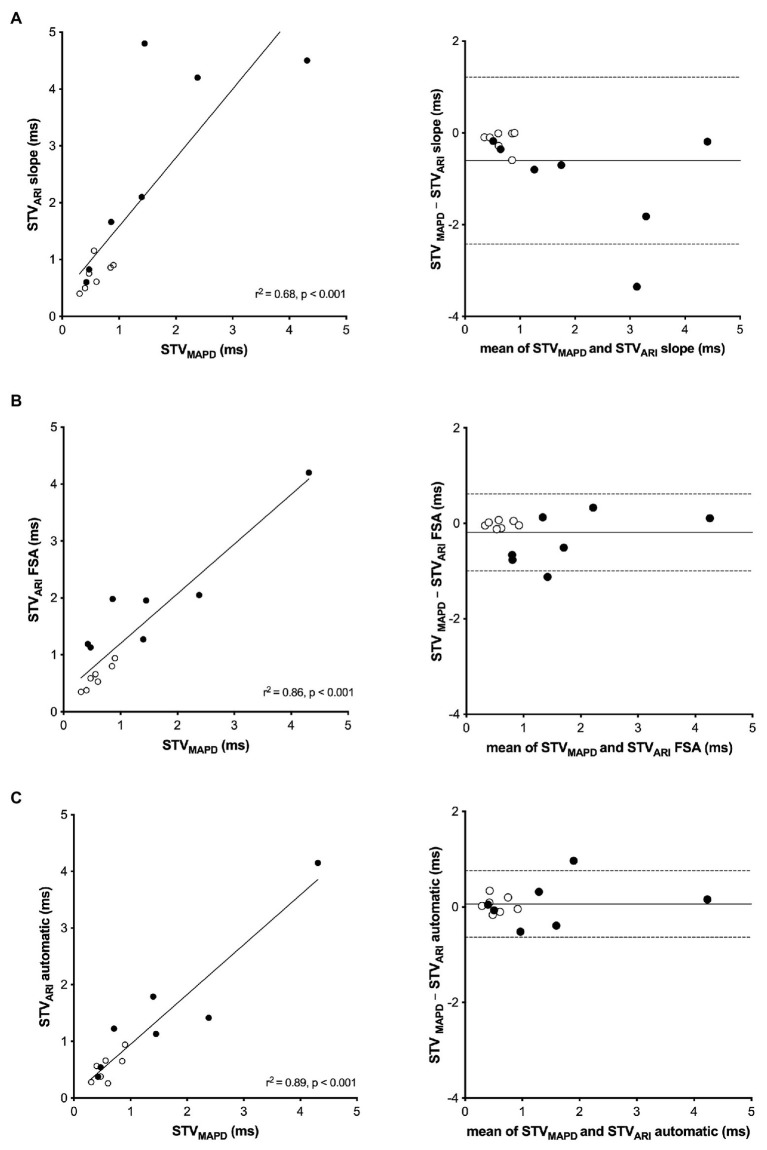
Linear regression and Bland-Altman analysis of STVARI compared to STVMAPD. (A) STVMAPD vs. STVARI measured with the slope method. (B) STVMAPD vs. STVARI measured with the fiducial segment averaging (FSA) method. (C) STVMAPD vs. STVARI measured with the new automatic method.